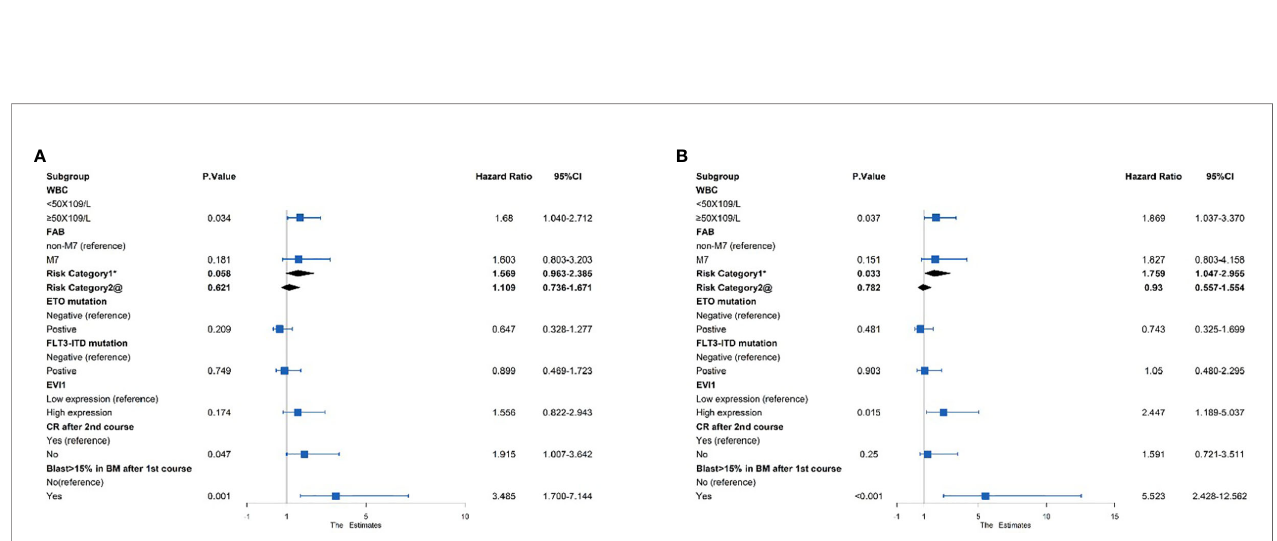
FIGURE 2 | Univariate Cox regression analysis of the (A) EFS and (B) OS among 383 pediatric AML patients. *Risk category based on treatment regimens. Refer to Supplementary Table S1 . @ Risk category based on cytogenetic strati fi cation of ELN